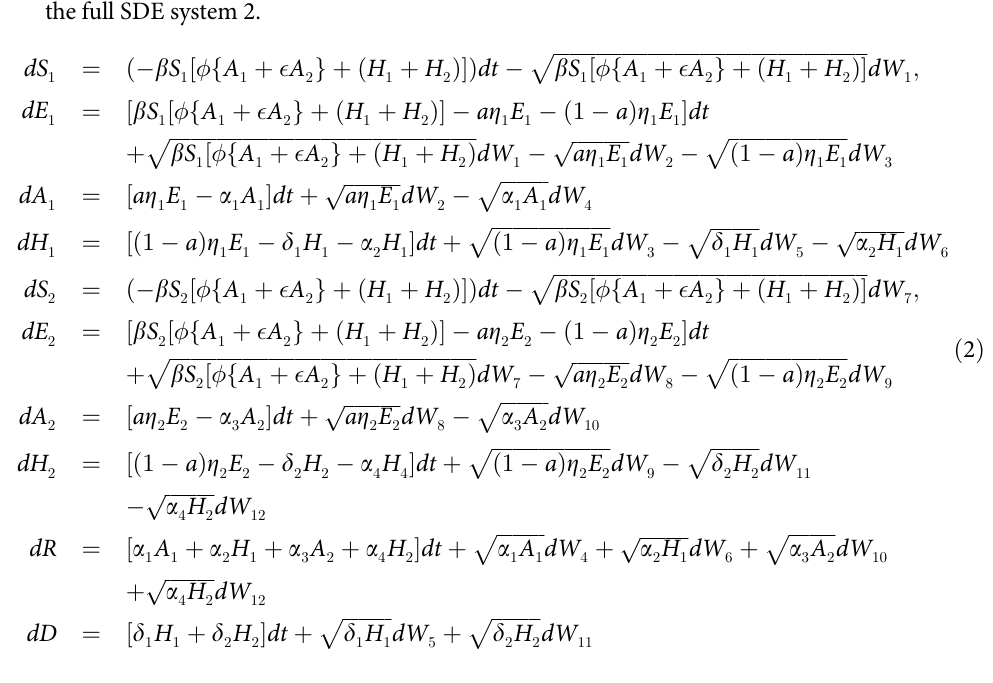
p ffiffiffiffiffiffiffiffiffiffiffiffiffiffiffiffiffiffiffiffiffiffiffi ð 1 (cid:0) a Þ Z